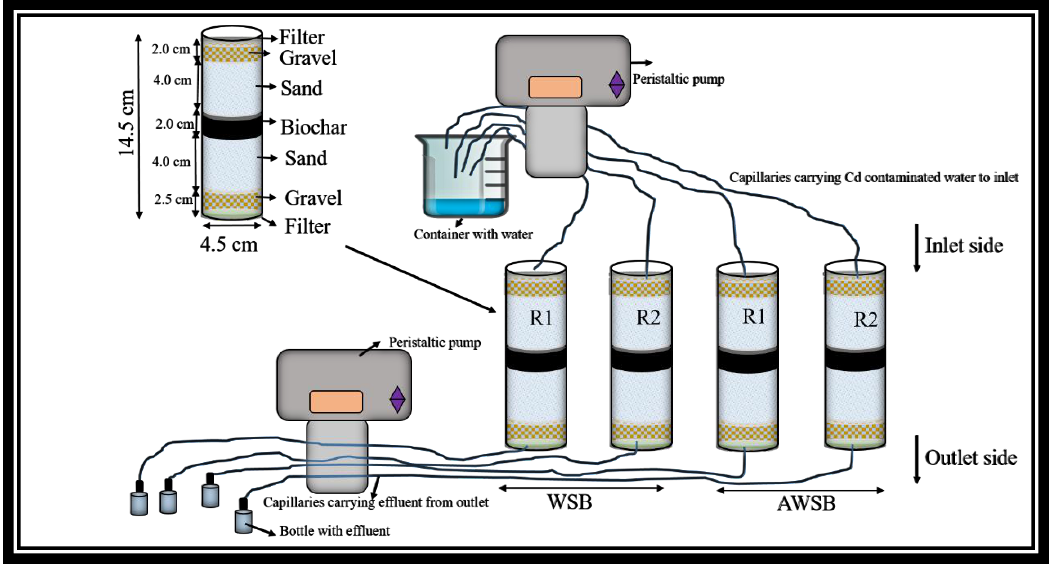
Figure 1. Schematic representation of column scale experiments in laboratory for the removal of Cd from water using wheat straw biochar (WSB) and acid treated wheat straw biochar